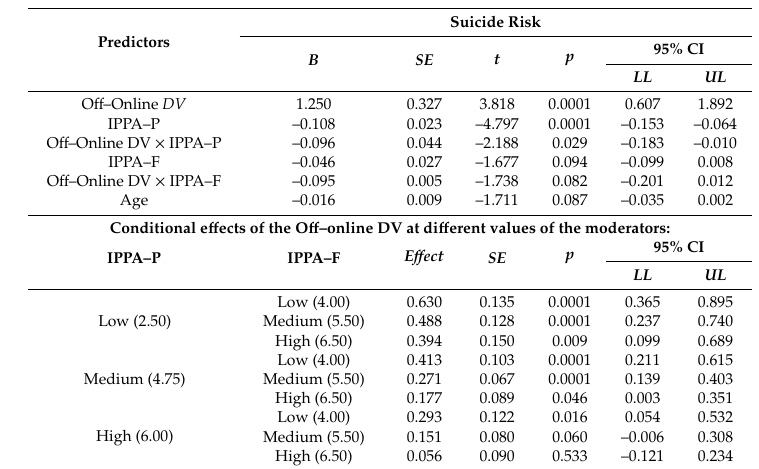
Table 6. Moderation Analyses: Conditional e ff ects of O ff -Online on Suicide Risk at Di ff erent Values of the IPPA–P,